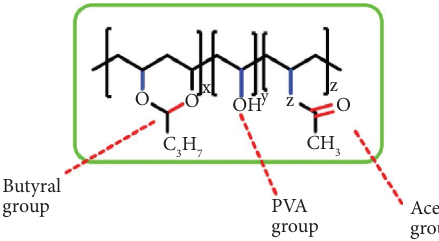
Figure 1: Chemical structure of polyvinyl